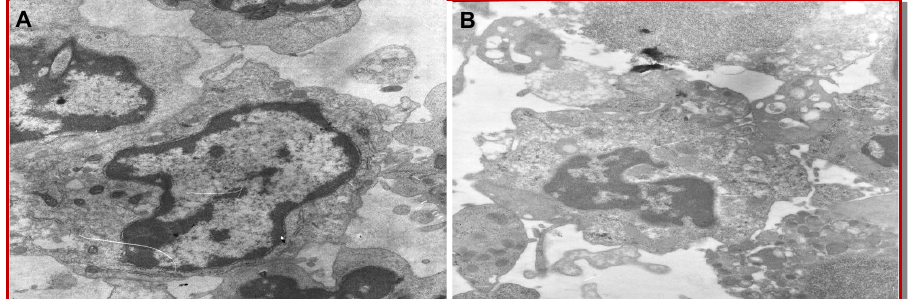
Figure 3: Morphology of SGC-7901 cells in different groups under transmission electric microscope. (A) Control; (B) ASODN group